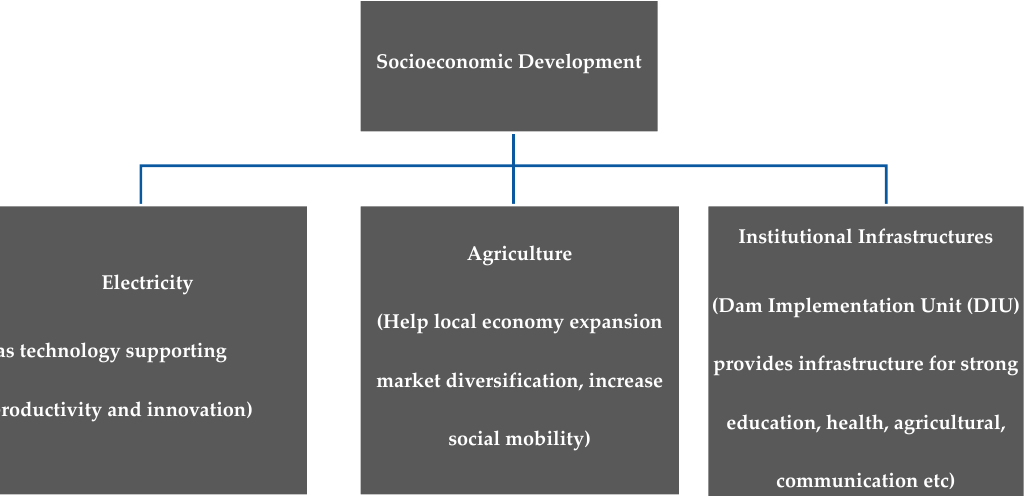
Figure 1. Conceptual framework for analyzing socioeconomic theory. Source: Author.